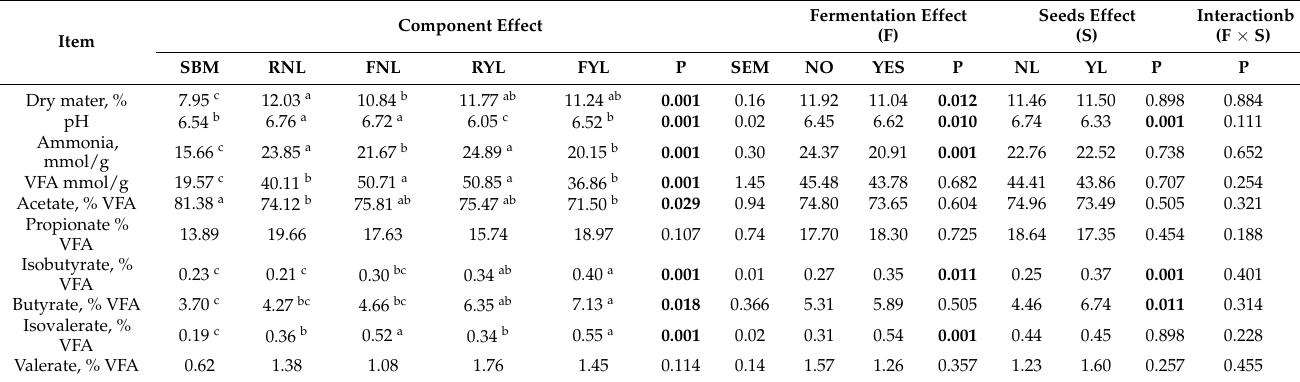
Table 6. Dry matter, pH, ammonia content and volatile fatty acids content and profile in ileal digesta of pigs ( n =